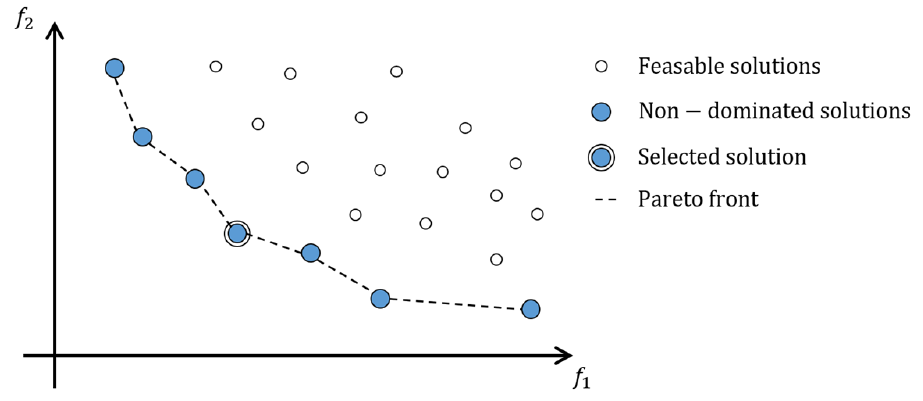
Figure 1. Example of a Pareto front.